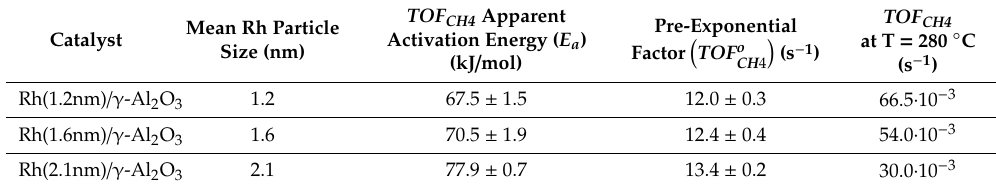
Table 3. Apparent activation energies and pre-exponential factors for CO 2 methanation reaction over Rh / γ -Al 2 O 3 catalysts with di ff erent mean Rh particle size, and TOF CH4 values at 280 ◦